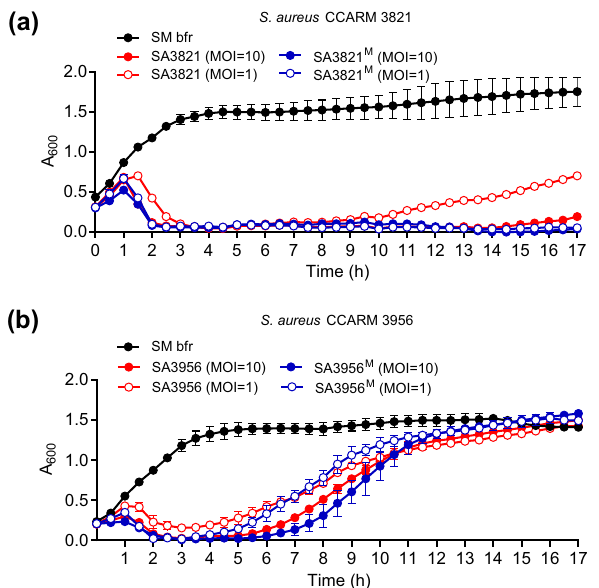
Figure 2. Bactericidal activities of parent and mutant phages. Growth of host S. aureus ( a ) CCARM 3821 and ( b ) CCARM 3956 was periodically monitored for 17 h after treatment with ( a ) parent SA3821 and mutant SA3821 M and ( b ) parent SA3956 and mutant SA3956 M at the indicated MOIs. SM buffer (SM bfr) instead